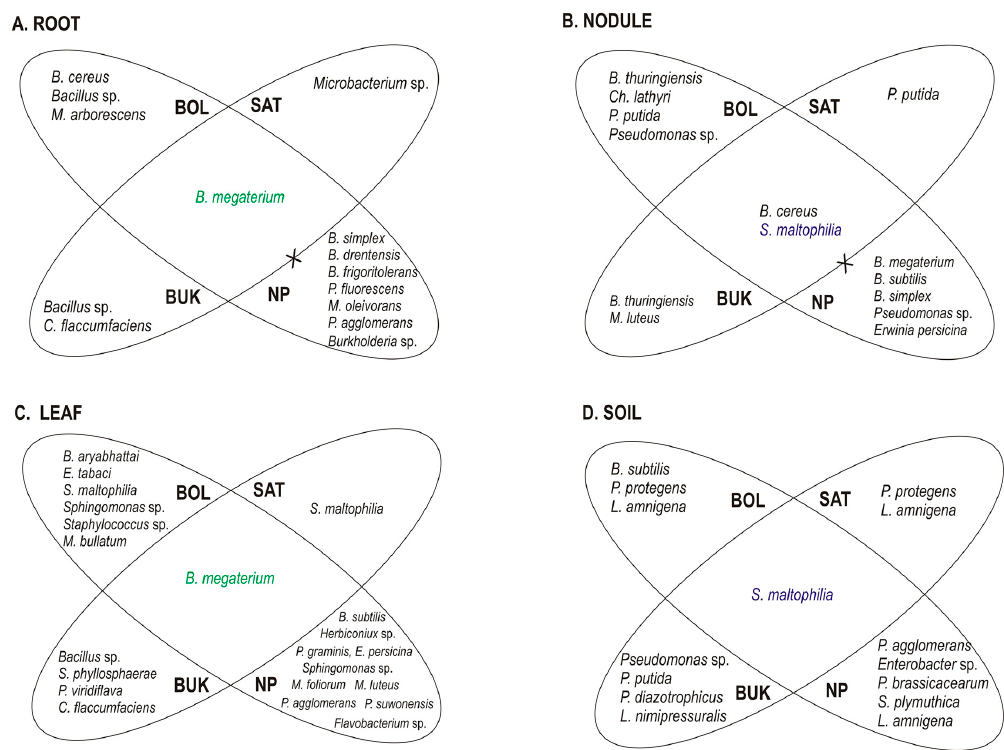
Figure 3. Shared and distinct bacterial taxa identified as root ( A ), nodule ( B ), and leaf ( C ) endophytes of T. repens and rhizosphere soil ( D ) originating from three metalliferous sites: Bolesław (BOL), Saturn (SAT), Bukowno (BUK), and the Bolestraszyce (NP) non-polluted reference site. Symbol X indices absence of common taxa.